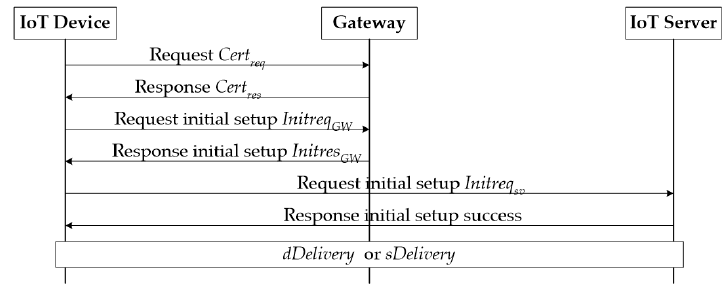
Figure 5. Initial setup between IoT device, gateway, and IoT